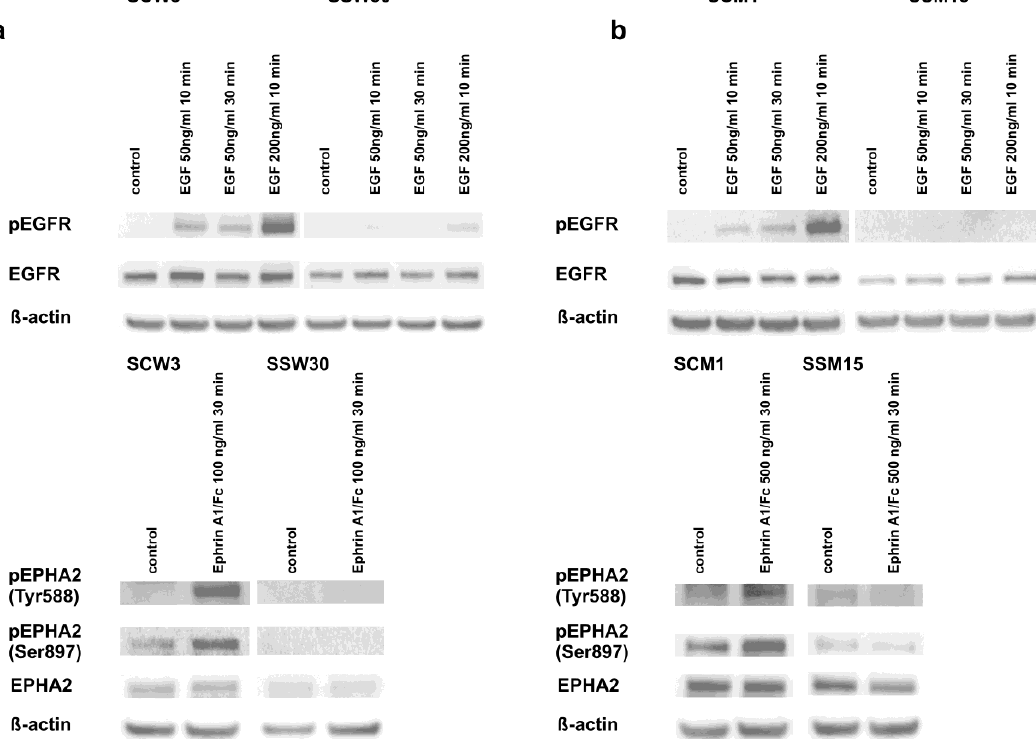
Figure 5. SIRT2 downregulation impairs the response of melanoma cells to EGFR and EPHA2 activators. The generated melanoma clones were treated with selected concentrations of EGF (EGFR activator) and ephrin A1 (EPHA2 activator) for 10 min and/or 30 min, respectively. Then, protein lysates were prepared and analyzed by Western blotting. ( a ) Experiments performed using WM853 SCW3 and SSW30 clones. ( b ) Experiments performed using MDA-MB-435S SCM1 and SSM15 clones.